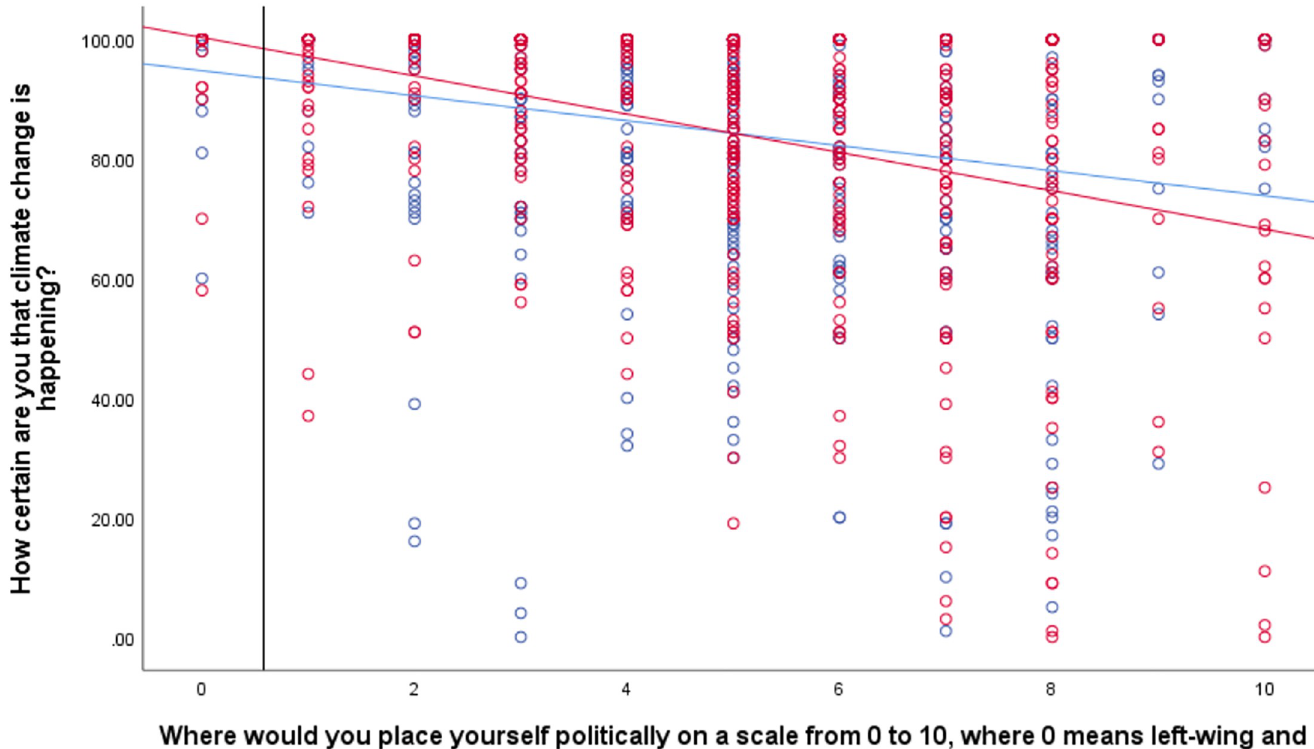
Fig 4. Association between political orientation and certainty that climate change is happening by temporal framing condition (past = blue, future = red). Solid vertical line represents the Johnson-Neyman value. To the left of this, the differences in certainty ratings by condition are significant.